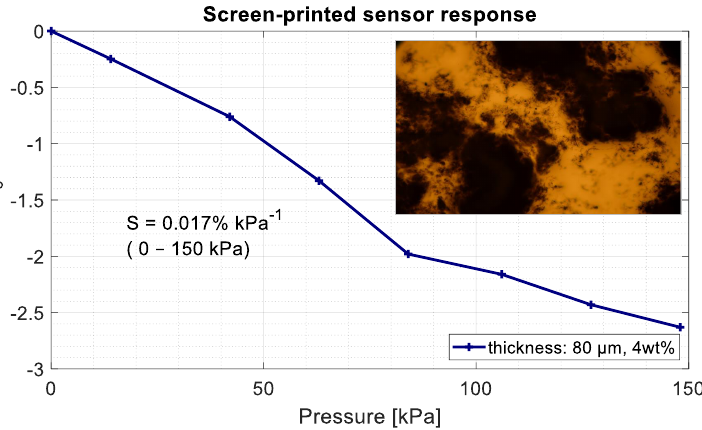
Figure 12. Screen-printed pressure sensor results. The resistance increases with the increasing